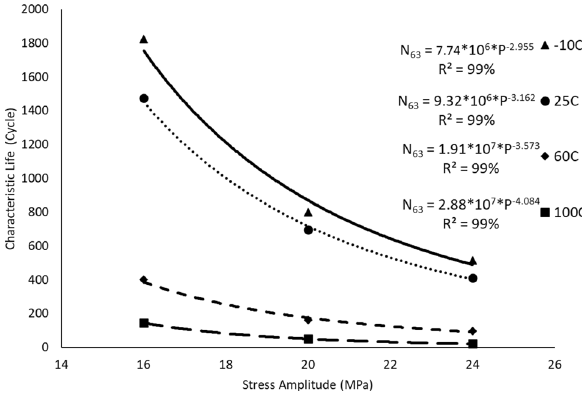
Figure 7. The stress-life equation at different testing temperatures.